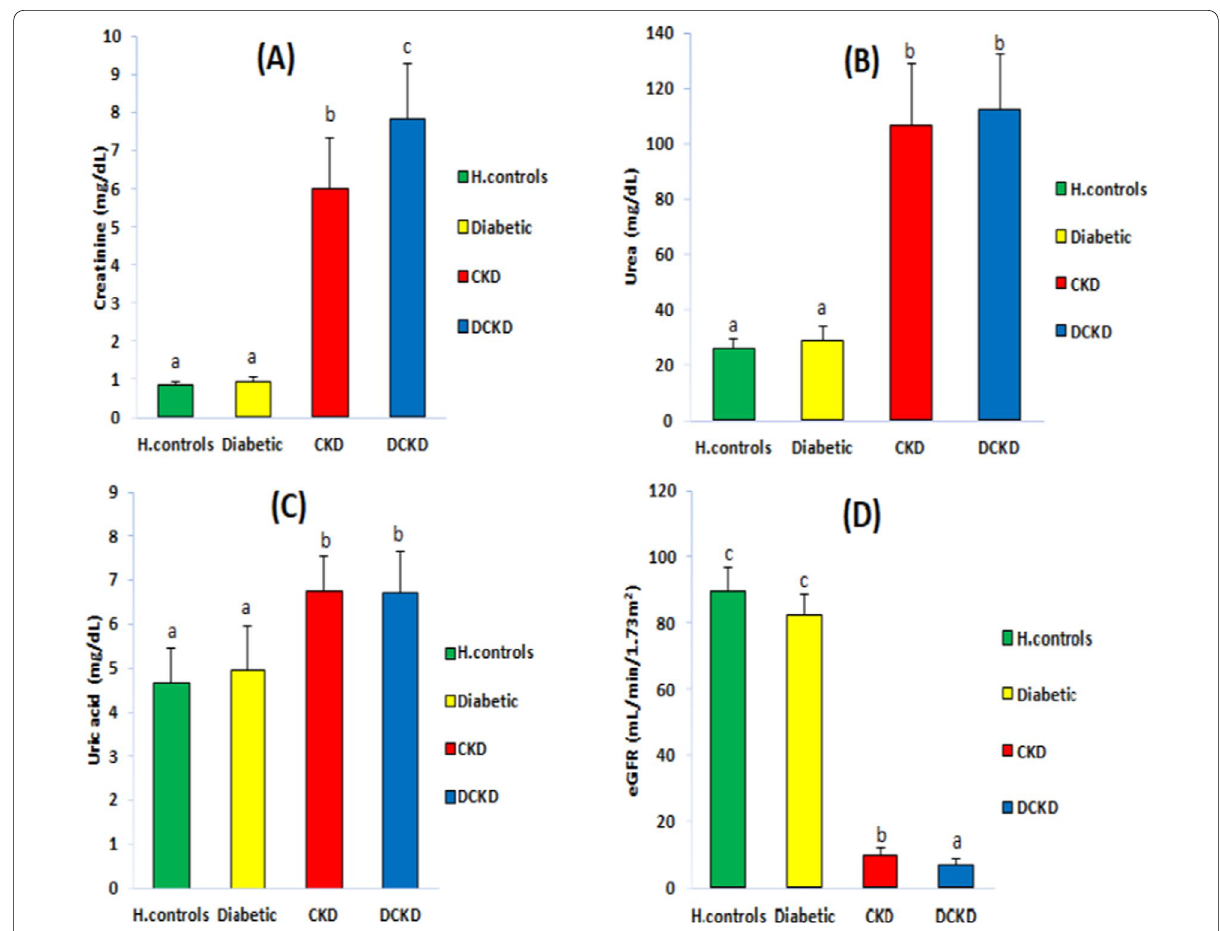
Fig. 1 The levels of A creatinine, B urea, C uric acid, and D eGFR in healthy control, diabetic, chronic kidney dysfunction (CKD), and diabetic chronic kidney dysfunction (DCKD) groups. Data are represented as mean SD. Different letters indicate significant differences ( p < 0.05). H.: Healthy, and ± GFR: estimated glomerular filtration